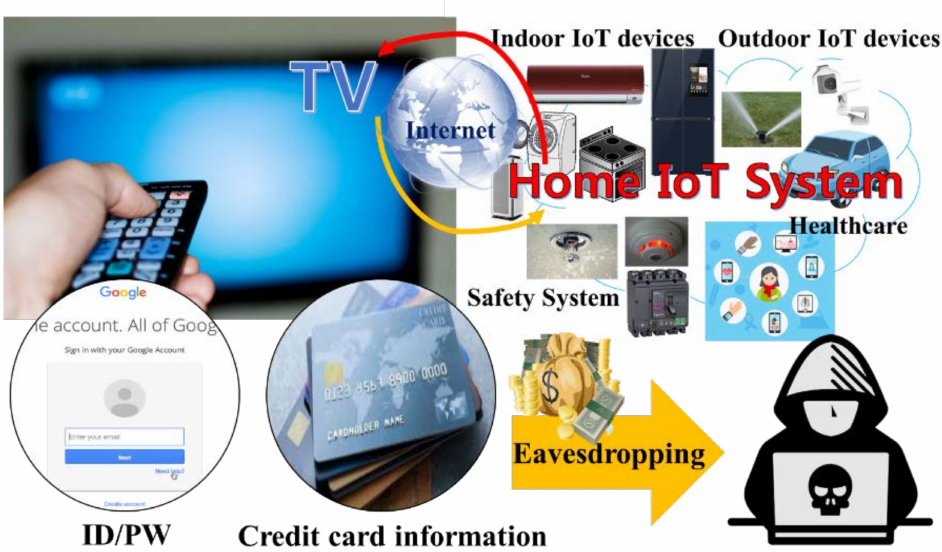
Figure 1. Eavesdropping threat when using infrared